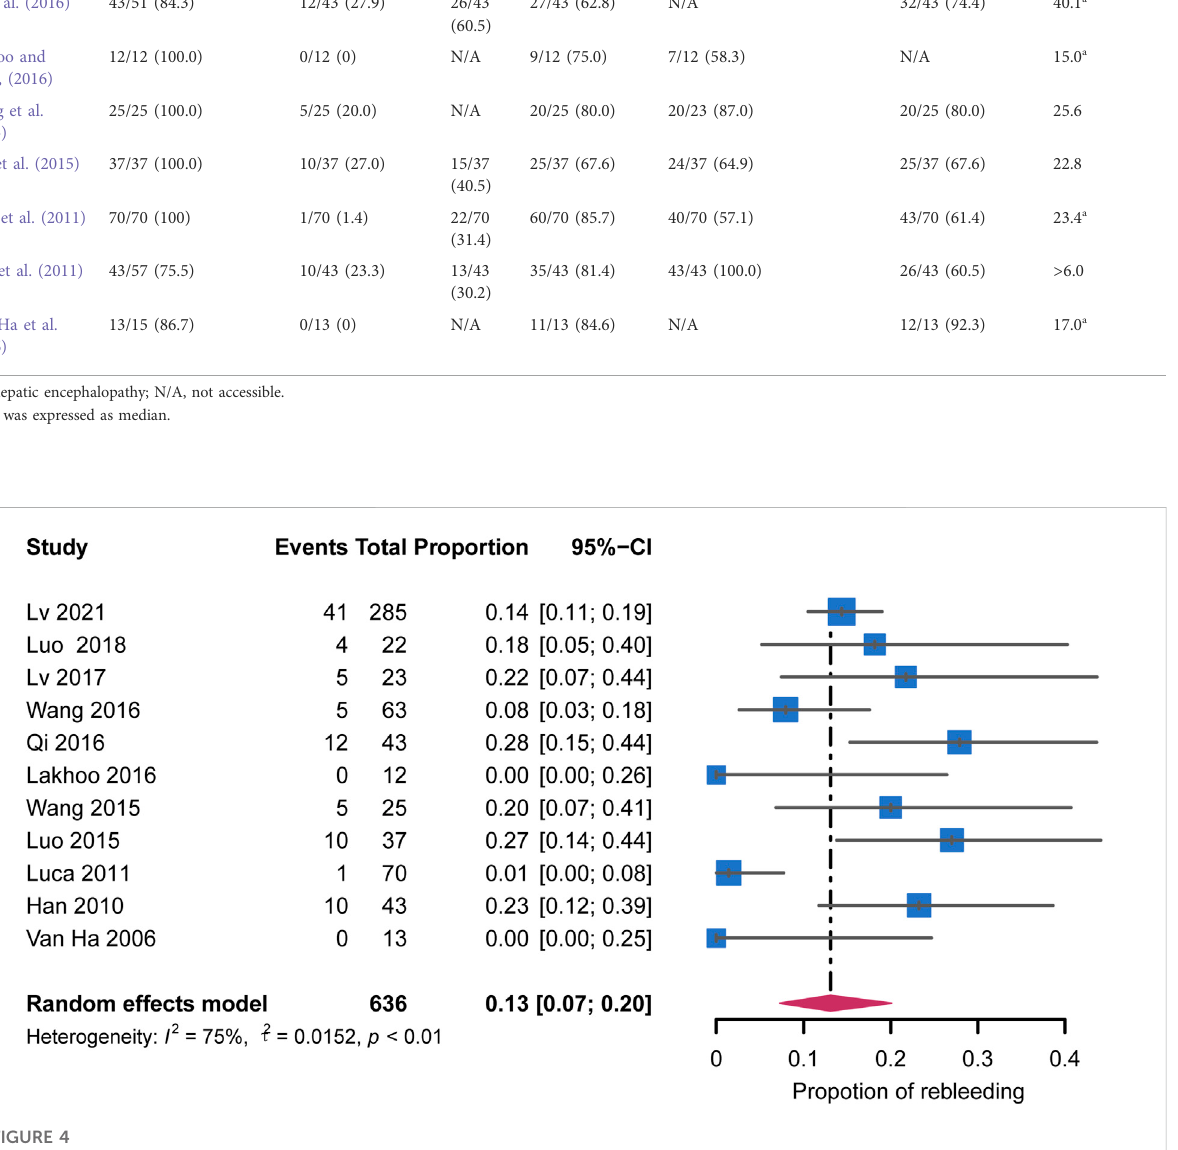
FIGURE 4 Forest plots for pooled rates of